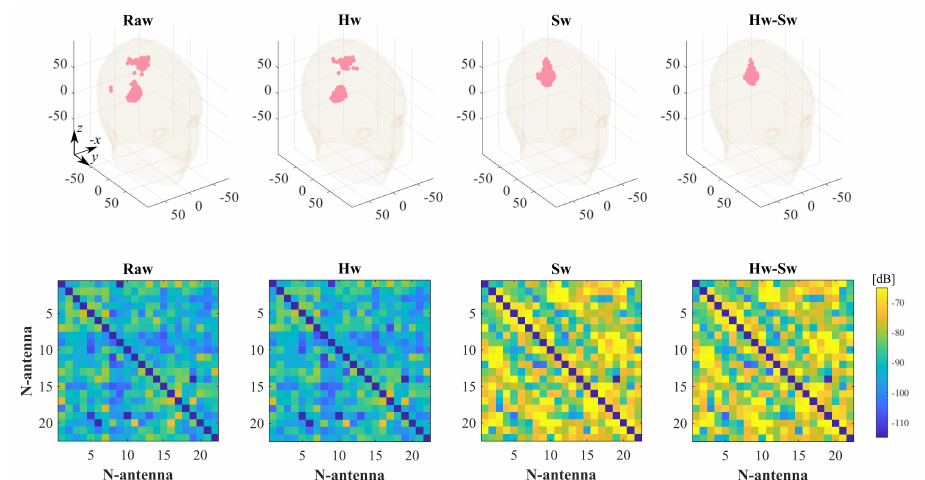
Figure 10. Calibration schemes applied to the ICH-HP_I case. Columns (from left to right): no calibration, Hw calibration, Sw calibration, and Hw and Sw calibrations. Top-row: normalized reconstructed dielectric contrast values above − 3dB (all the units are in mm); bottom-row: differential scattering matrices’ amplitude values in dB (the main diagonal is not shown).